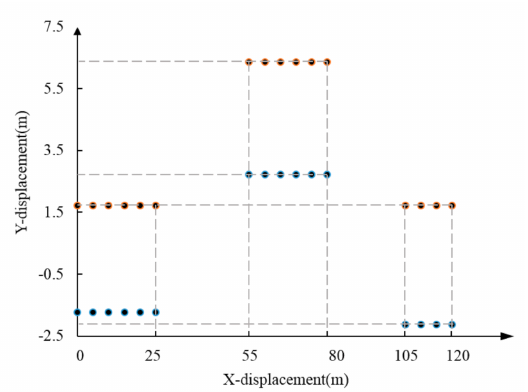
Figure 7. The double lane change (DLC) test Lane layout.